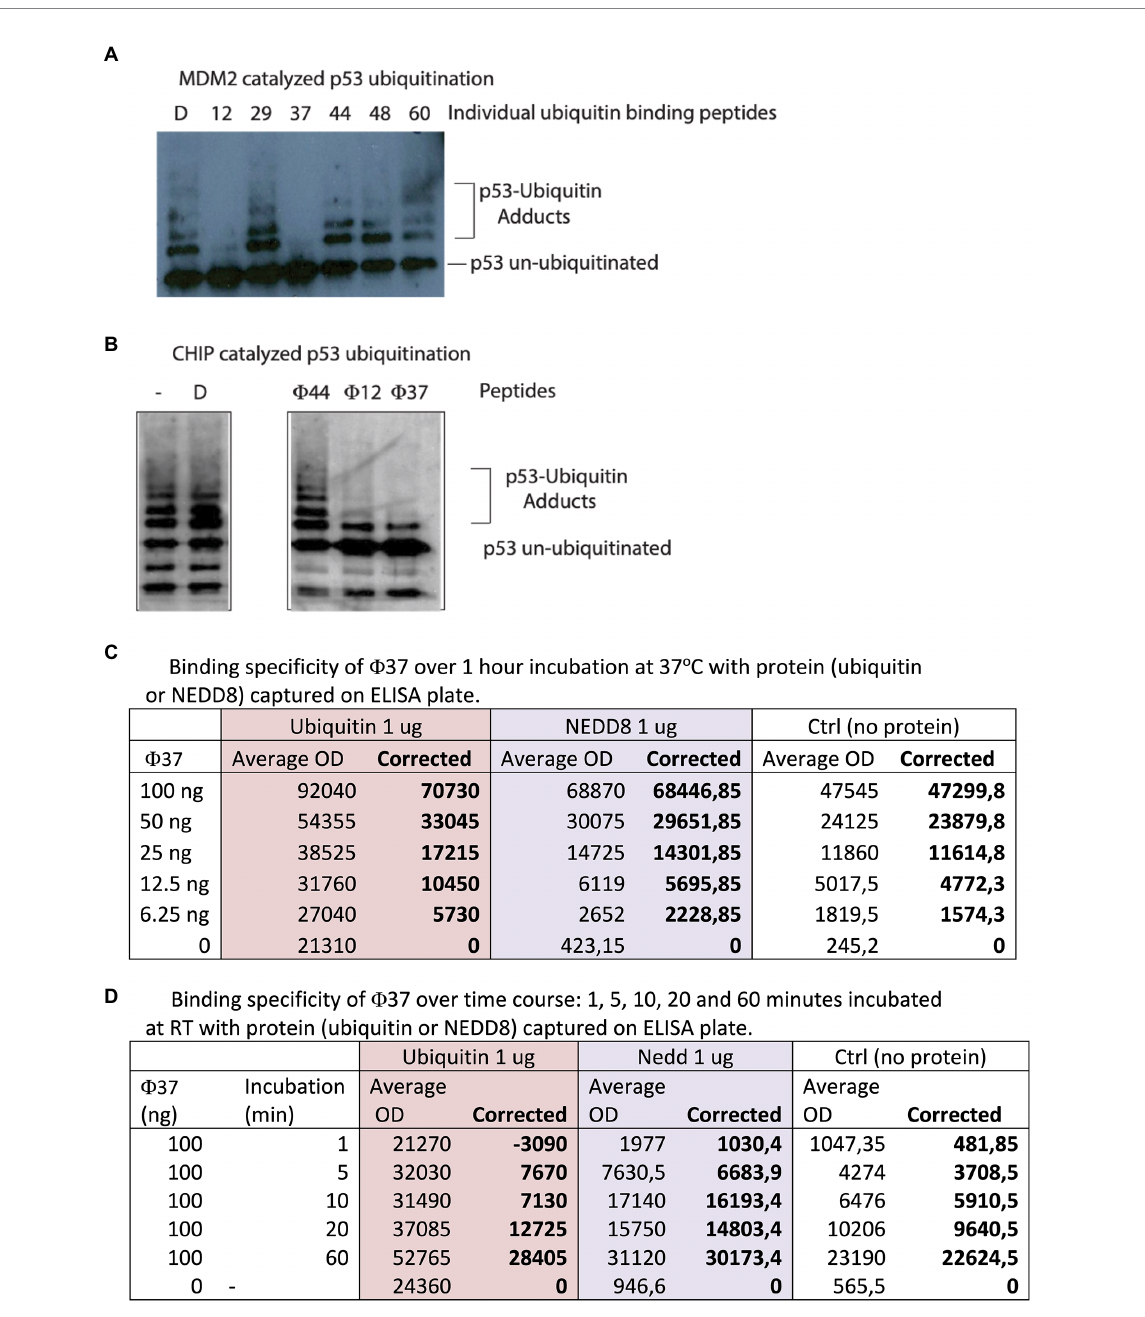
FIGURE 2 Identification of peptides with bioactivity in ubiquitin assays. (A) Ubiquitin assays driven by the E3 ubiquitin ligase MDM2 were assembled with individual peptides from the reactive pools derived from the 60 peptides in Supplementary Table 3. Representative assay showing that specific peptides such as 12 and 37 reproducibly inhibited MDM2 catalyzed ubiquitination (from the left, lanes 2 and 4 vs. lane 1 DMSO-only control). (B) Ubiquitin assays driven by the E3 ubiquitin ligase CHIP were assembled with individual peptides (labeled Φ ) that were active in inhibiting MDM2- driven reactions (12 and 37) and a non-active ubiquitin-binding peptide 44 (Figure 2B). D represents DMSO-only control. Reactions were processed by immunoblotting to detect changes in p53 ubiquitination as indicated in the methods. (C,D) Analysis by ELISA of peptide-37 activity with a C-terminal biotin tag. Ubiquitin or NEDD8 was coated on the solid-phase to mimic the original peptide-phage screen. Peptides were added and then either titrated in duplicates as indicated from 6.25–100 ng for 60 min (C) or else fixed peptide levels (100 ng) were added in duplicates as a time course from 1 to 60 min (D) . The data are tabulated as binding in ECL